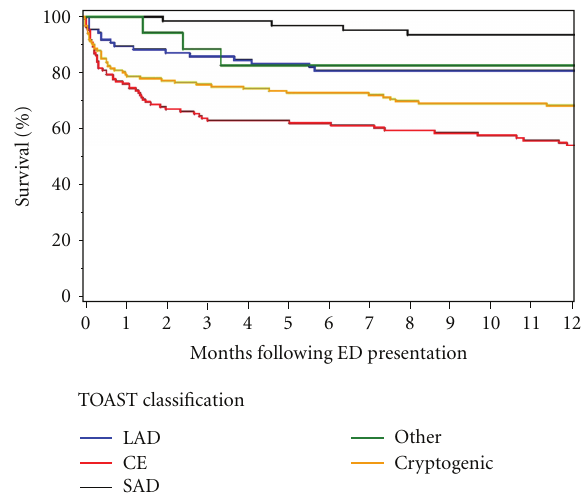
Figure 1: Survival estimates by TOAST